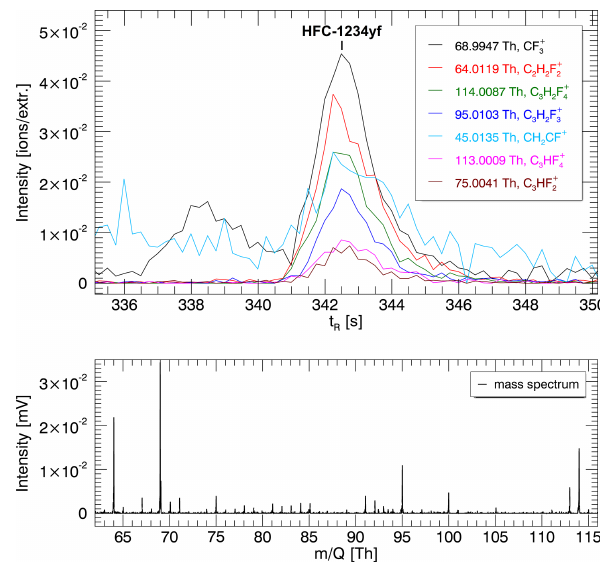
Figure 3. Upper graph: chromatographic signal of HFC-1234yf (CH 2 CFCF 3 ) at a retention time ( t R ) of 343s observed in an air sample from a parking lot. Lower graph: mass spectrum excerpt at the chromatographic peak apex. Y axis unit conversion, lower to upper graph: divide by the number of extractions per spectrum and the signal intensity of a single ion (determined